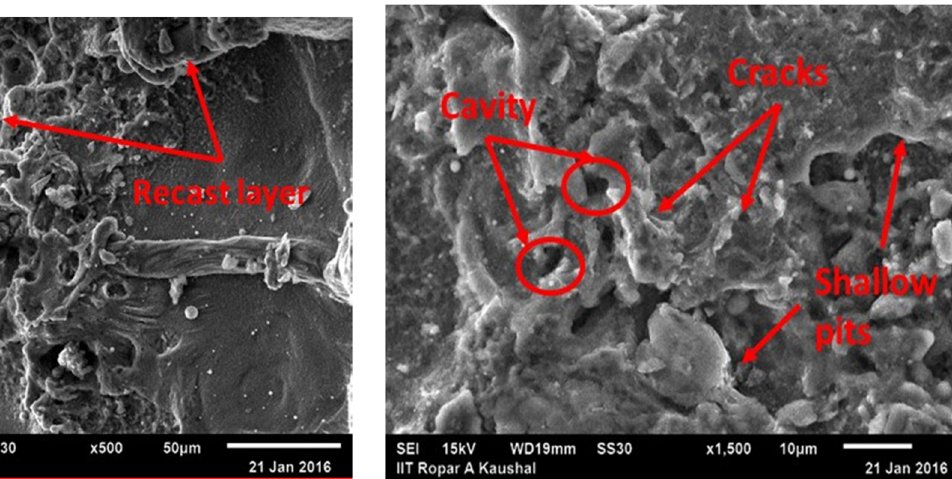
Figure 5: SEM image of Al/10 wt%SiC/3 wt%Gr – MMC hybrid com - posite after machining.